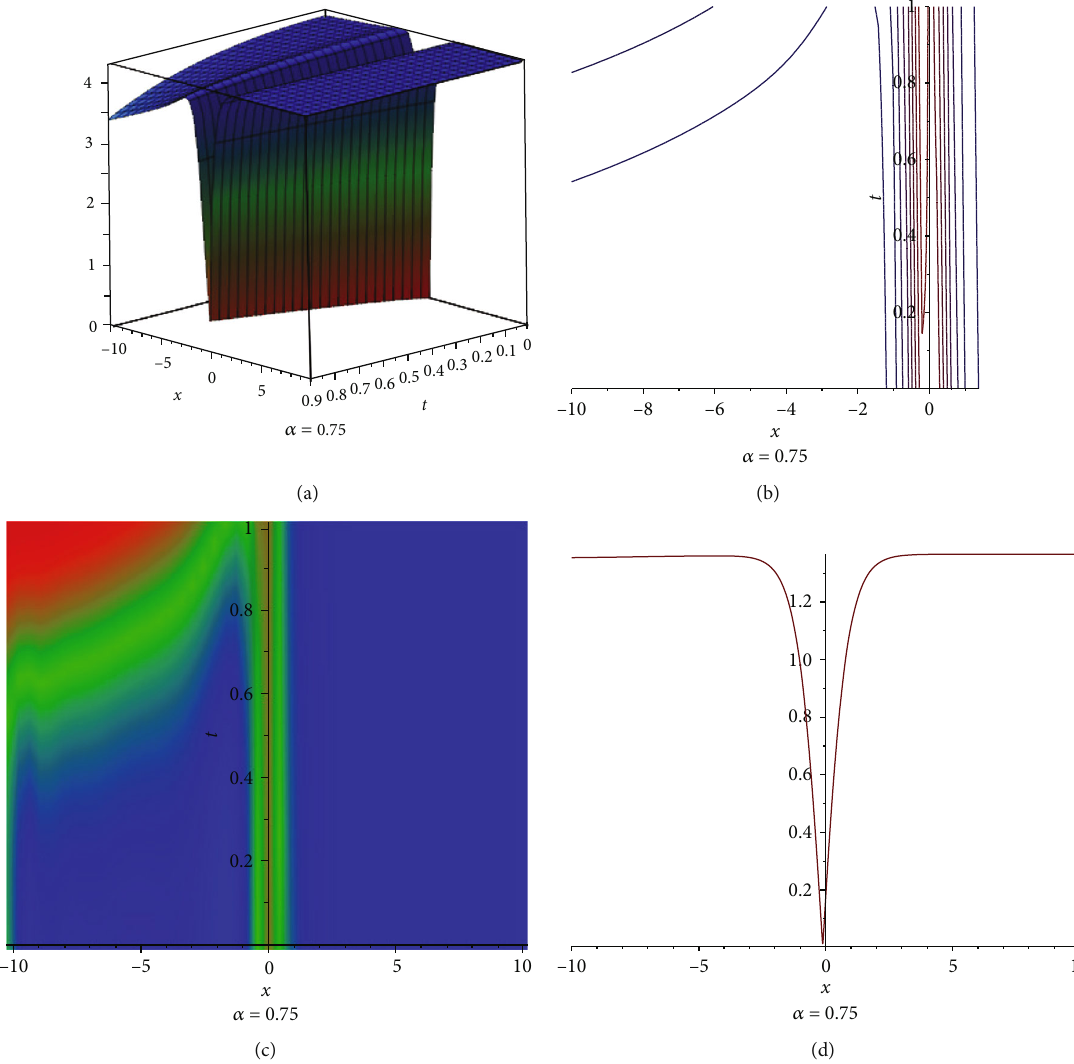
Figure 2: The graphical representations of j U 1